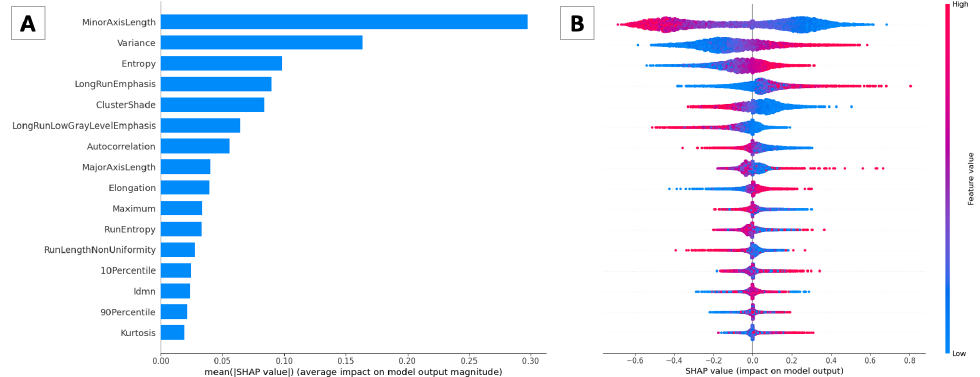
Figure 7. ( A ) Bar plot . The plot depicts the average impact of the considered features according to the magnitude of the SHAP values. The most important feature is MinorAxisLength . ( B ) Summary plot . The plot displays the fusion between feature importance and feature effects by plotting a point for each Shapley value belonging to a feature and an instance. Higher values of MinorAxisLength are associated with a greater risk of being a tumor